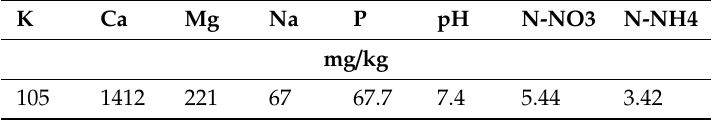
Table 1. Soil physico-chemical analysis results of the soil used in the study.